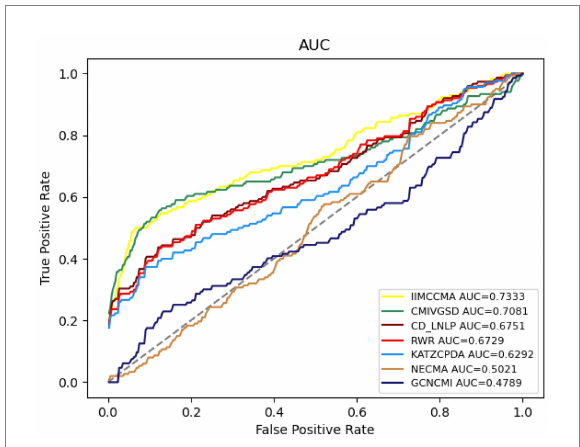
FIGURE 6 Performance comparison between IIMCCMA model and benchmark model.